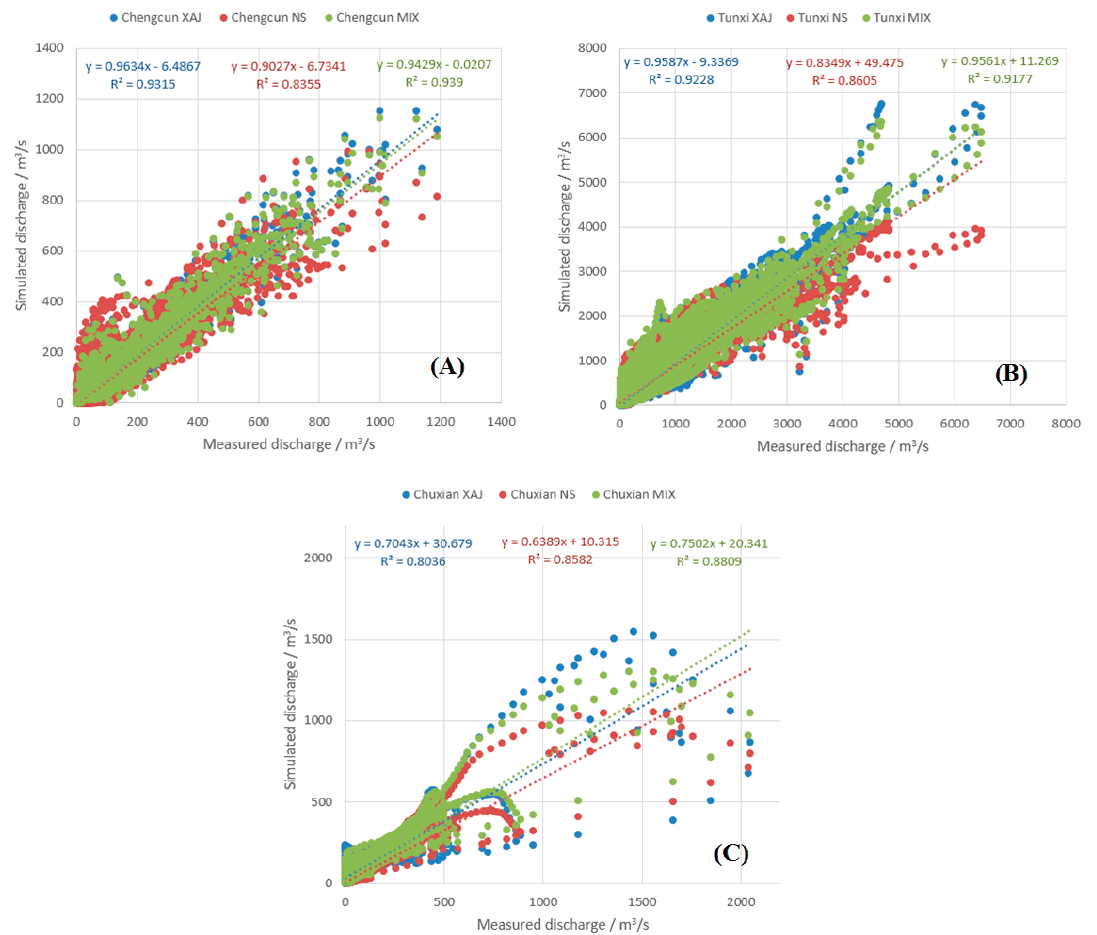
Figure 10. Scatter plots of observed and simulated discharges for humid regions; ( A ) Chengcun; ( B ) Tunxi; ( C ) Chuxian.